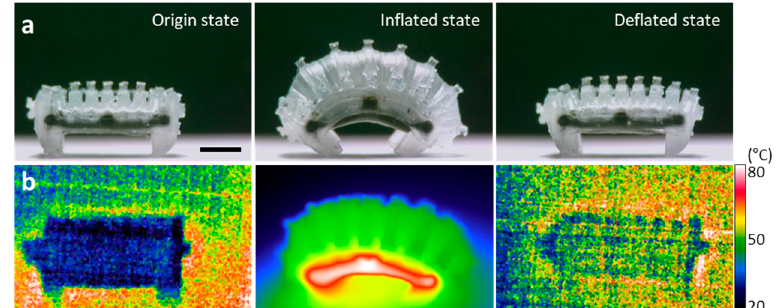
Figure 5. One-cycle operation process showing operation mechanism of WIBot. ( a ) Optical image showing movement distance of WIBot. The scale bar represents 2 mm. ( b ) Infrared image showing WIBot temperature. WIBot